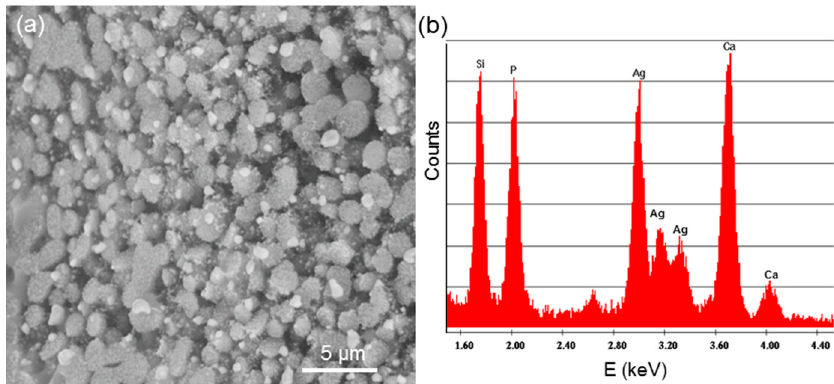
Figure 6. In vitro bioactivity tests carried out on TT-FaGC samples: ( a ) sample surface after soaking for seven days in SBF and ( b ) corresponding EDS pattern.